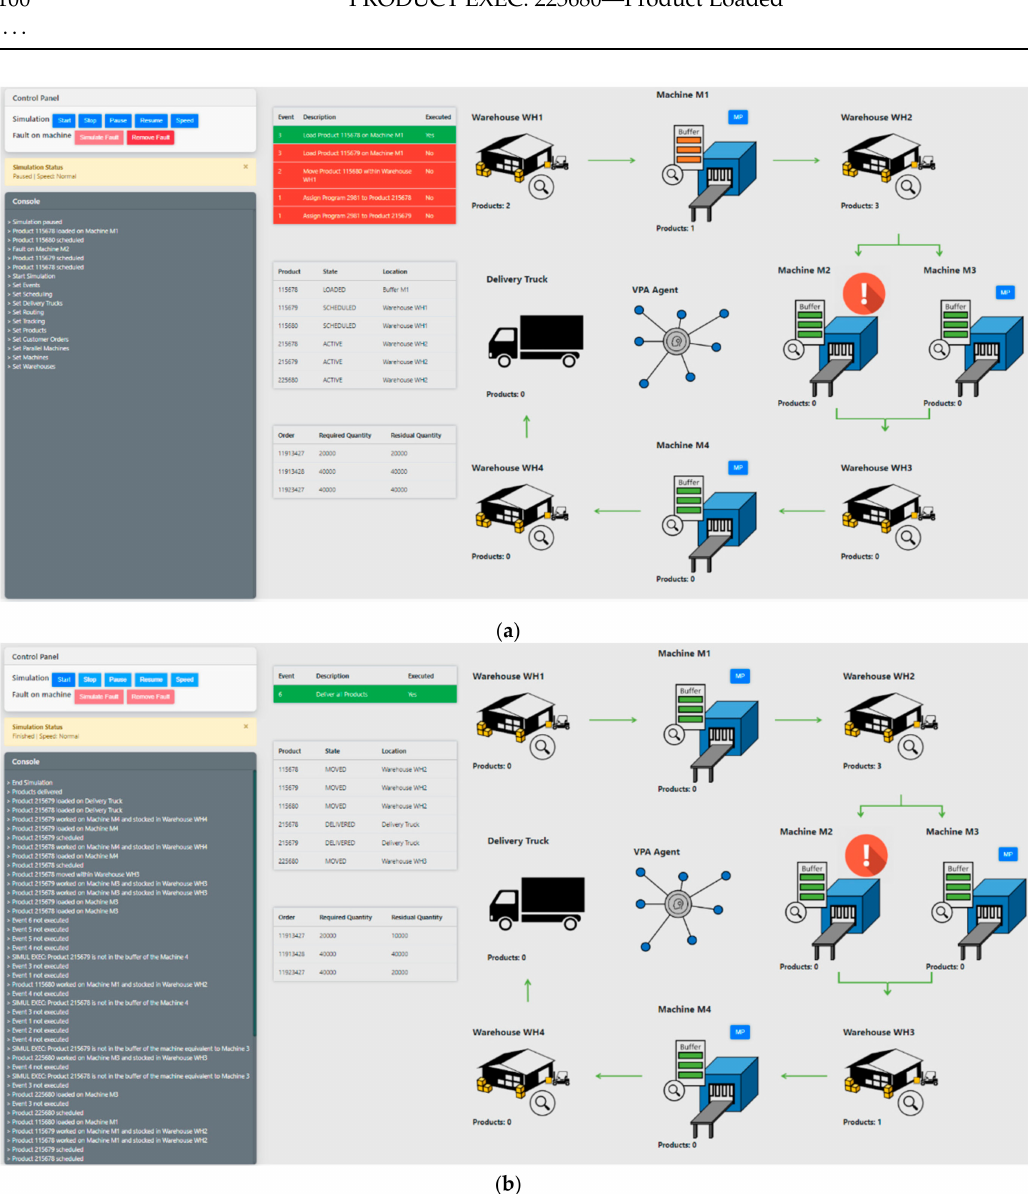
Figure 14. ( a ) Machine fault scenario at the beginning of the simulation; ( b ) Machine fault scenario at the end of the